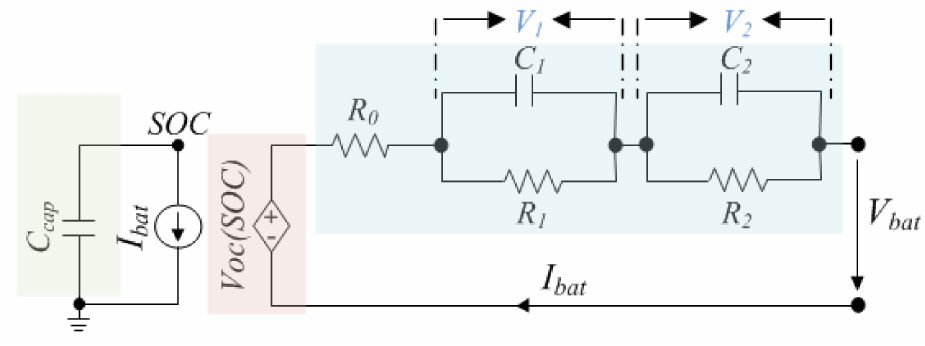
Figure 1. Proposed equivalent electrical